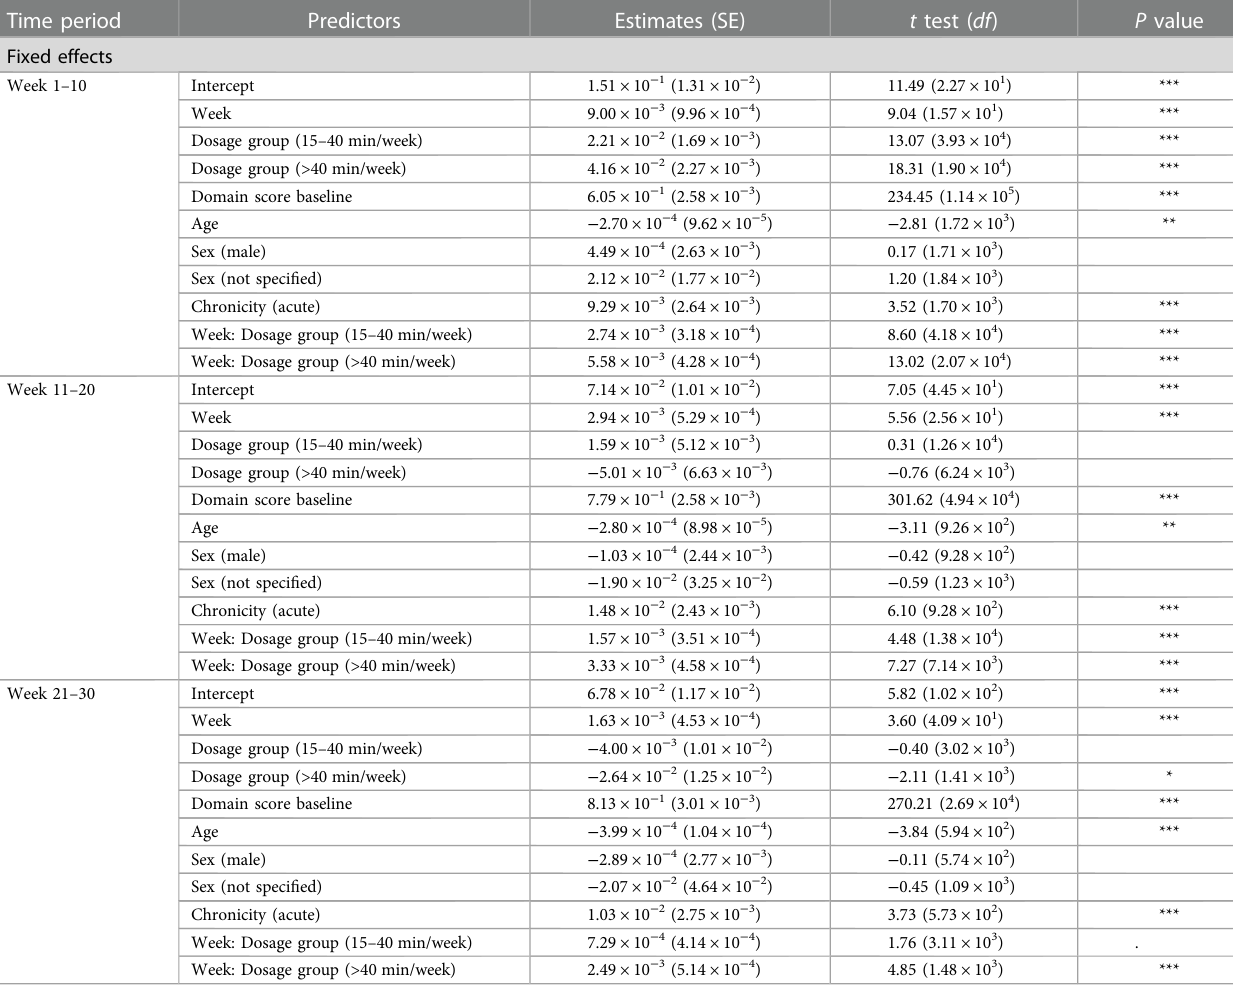
TABLE 6 Final linear mixed-effects model results summary of the variable cohort ( fi xed